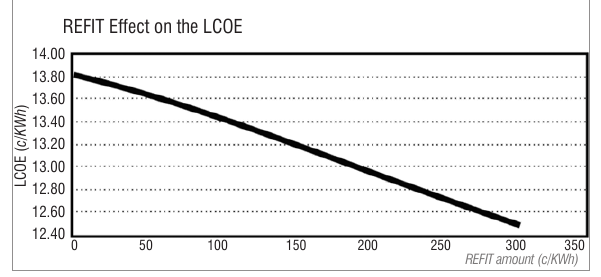
Figure 8: Graph illustrating the effect of an added renewable energy feed- in tariff (REFIT) on the levelised cost of electricity (LCOE) for a hypothetical enhanced geothermal system.